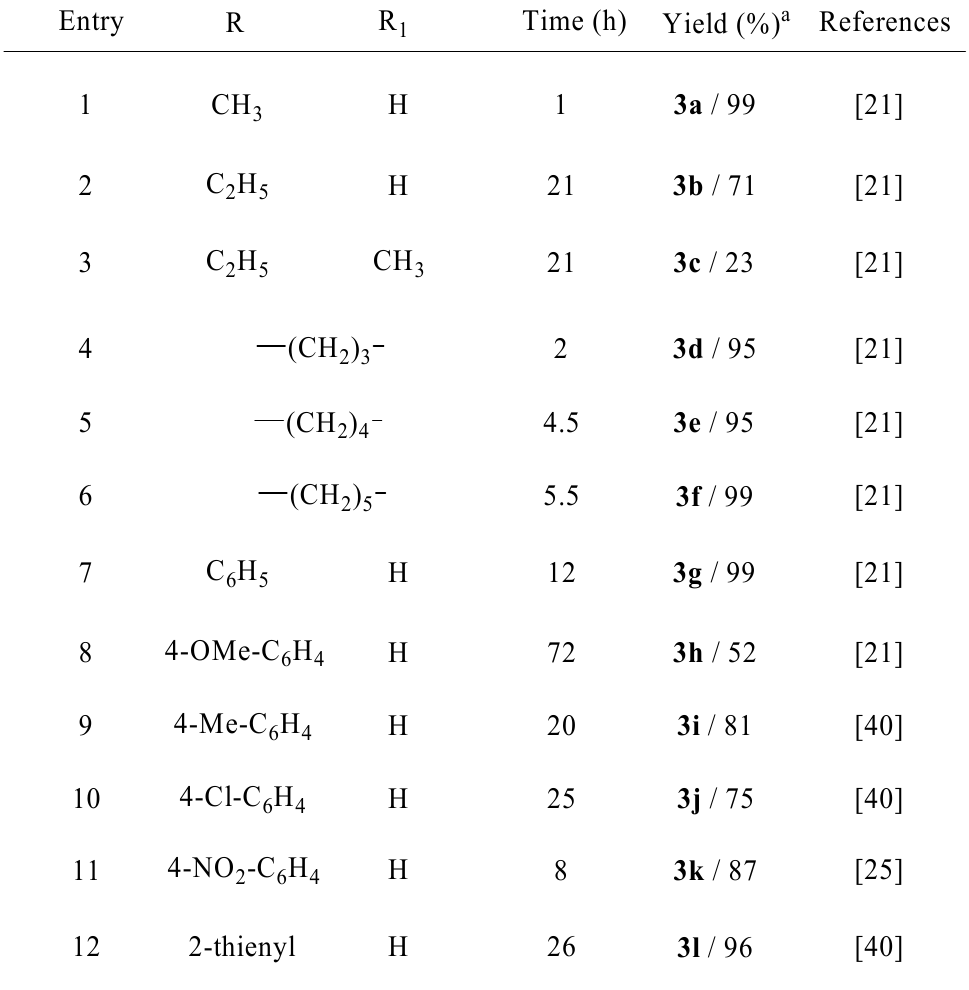
Table 2. The results of the reaction of o -phenylenediamines with various